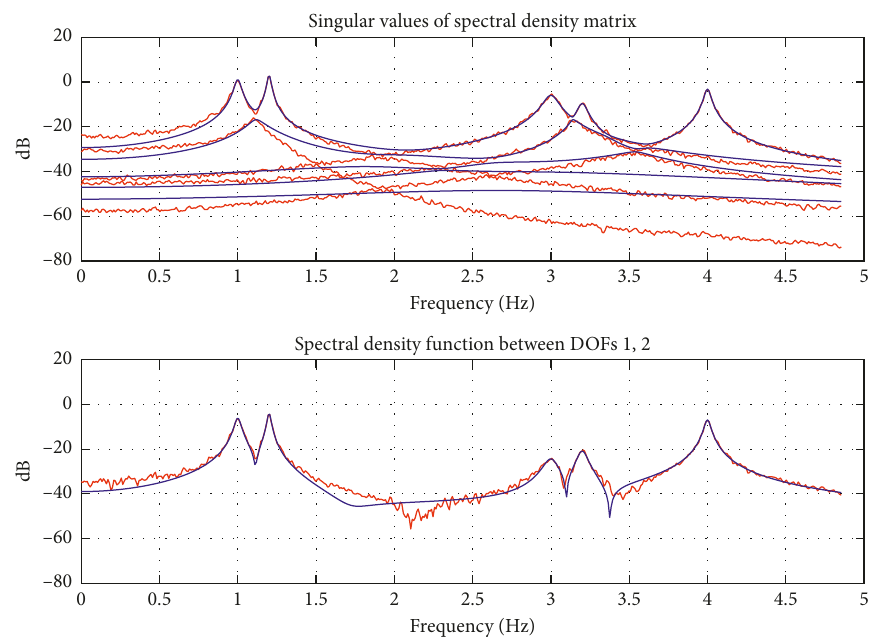
Figure 2: Estimated empirical density functions of the simulation case (red) and synthesized density functions (blue). Top plot shows the singular values, S ( ω ) , of the spectral density matrix, whereas the bottom plot shows the cross spectral density function, g